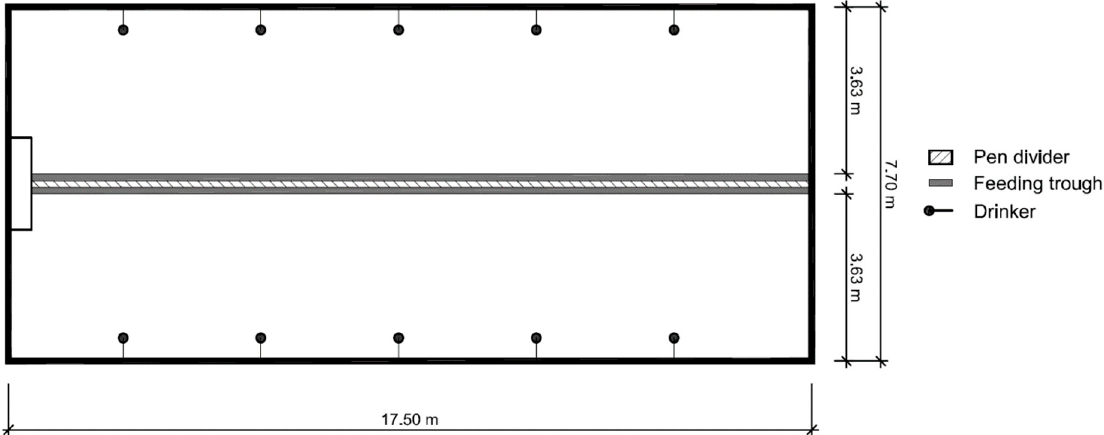
Figure 1. Floor plan of the existing system.